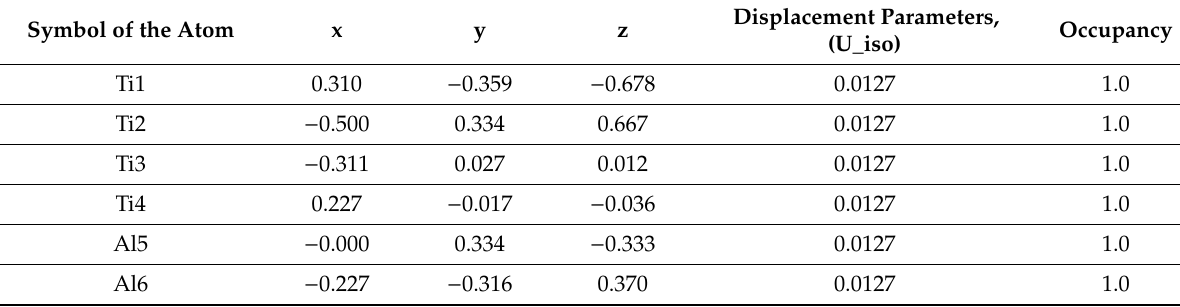
Table 5. Relative coordinates of the atoms in the TiAl-Struct2